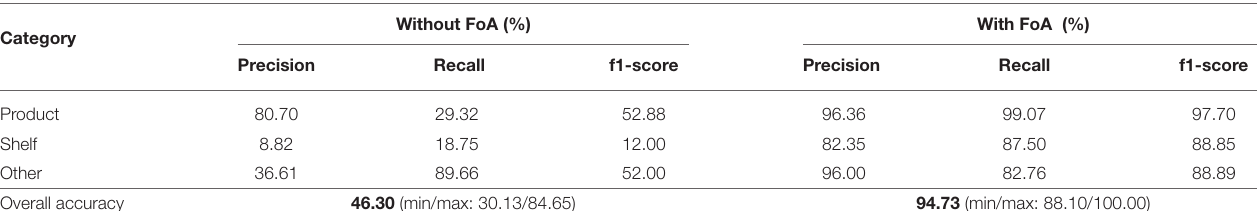
Bold values indicate the average accuracy after 10-fold